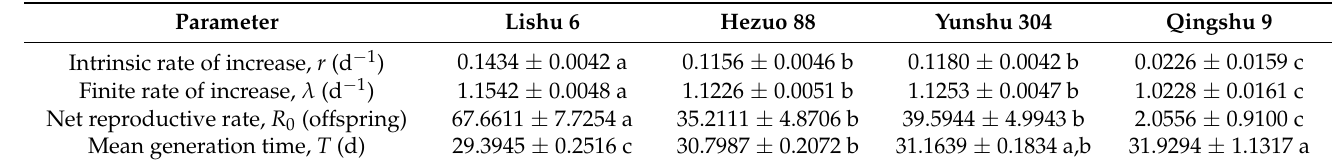
Table 2. Population parameters of P. operculella on four different potato tuber varieties. Parameter Lishu 6 Hezuo 88 Qingshu 9 Intrinsic rate of increase, r (d − 1